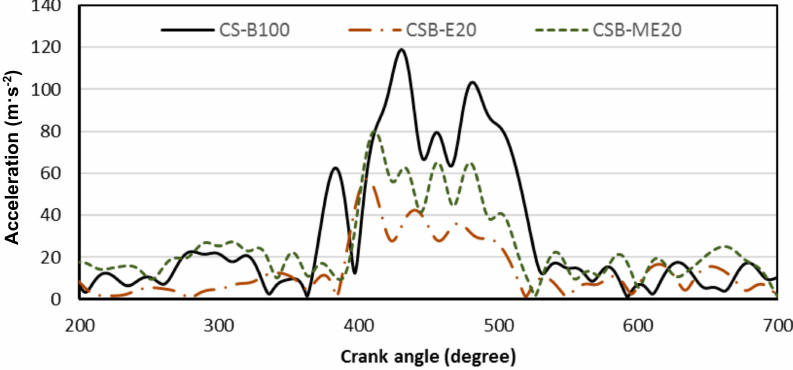
Figure 5. Vibration at engine speed 3670